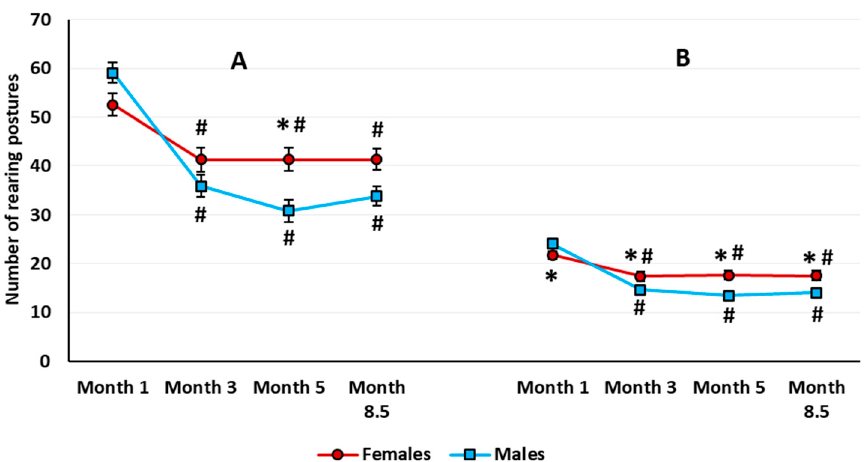
Figure 4. The total number of rearing postures over 10 min ( A ) and in the first 3 min ( B ) in female and male rats in the automated open field test. The # indicates a statistically significant di ff erence compared with the number of rearing in the 1-month-old rats of the same sex, p < 0.001; the * indicates p < 0.001 compared with the number of rearing in males of the same age (ANOVA followed by the Newman–Keuls post hoc test). See Supplementary Materials, Table